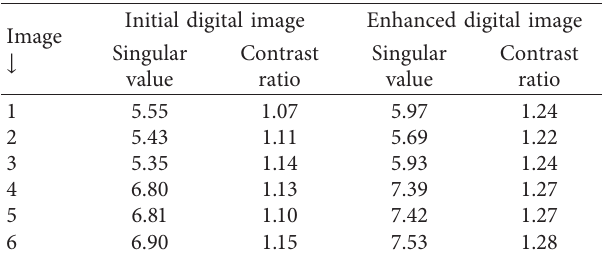
Table 3: Contrast and entropy increment of images before and after